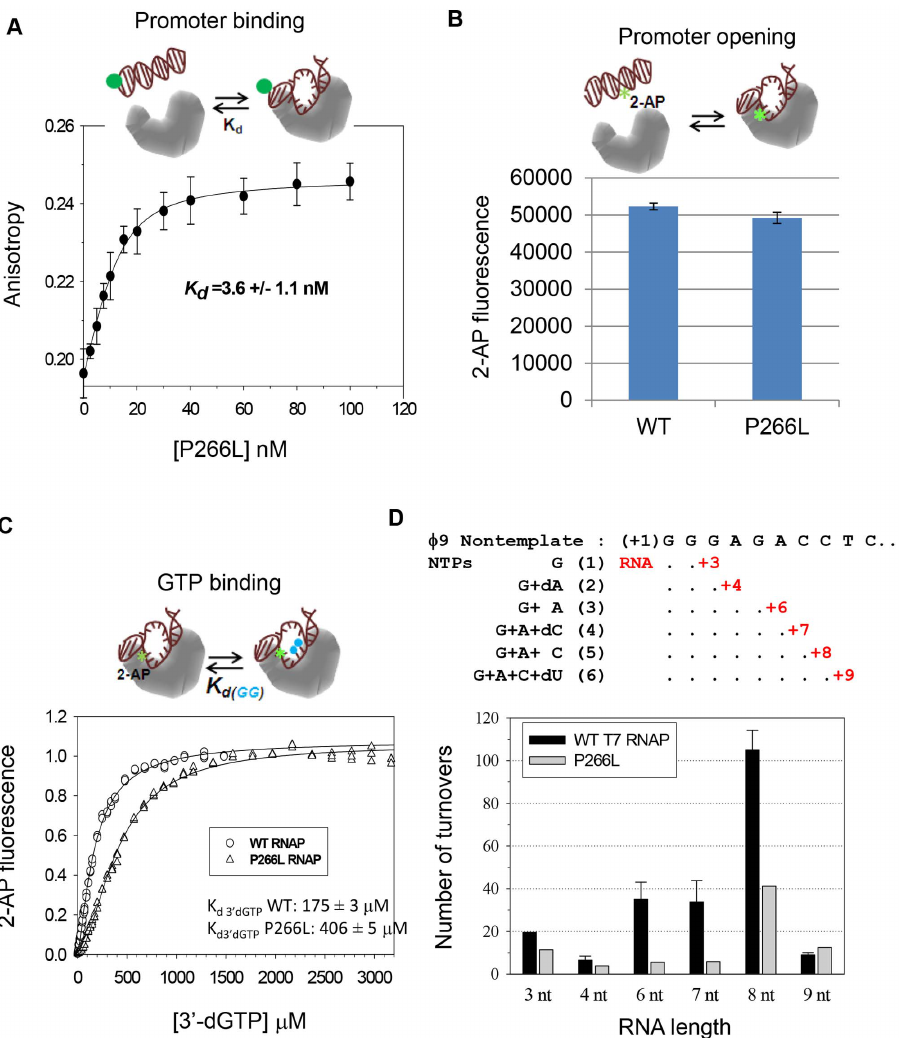
Figure 3. Promoter binding, opening, GTP binding and RNA turnover. (A) TAMRA fluorophore labeled promoter DNA (20 nM) was titrated with increasing P266L T7 RNAP (0 to 100 nM) and increase in fluorescence anisotropy was fit to the quadratic equation with K d of 3.6 6 1.1 nM. Similar to the WT T7 RNAP, the P266L mutant did not cause significant changes in the TAMRA fluorescence intensity ( , 10%) upon binding. Effect of the intensity changes on the fitting was insignificant and corrected the same way as reported previously [23]. Shown here are averaged values with standard deviations (error bars) from multiple independent measurements, from which K d was fitted. (B) The increase in 2-AP fluorescence at 2 4 in the template strand upon addition of WT and P266L indicate slightly lower promoter opening with P266L. The errors are standard deviation from 10– 15 measurements. (C) Initiating GTP binding was monitored from fluorescence increase in the 2-AP ( 2 4 position) labeled promoter DNA bound to T7 RNAP titrated with increasing 3 9 dGTP. The P266L binds to the initiating NTPs (3 9 dGTP) , 2 times weaker than WT T7 RNAP (175 m M versus 405 m M) and Hill coefficients are 1.3 6 0.02 and 1.7 6 0.03 for WT and P266L, respectively. The errors represent the fitting uncertainty. (D) A complex of WT or P266L T7 RNAP (2 m M) and promoter DNA (1 m M) was mixed with limited NTPs or NTP and 3 9 -deoxy NTP mixture for 2 min at 25 u C to allow RNA synthesis of the indicated lengths. The amount of RNA shown in m M is representative of the number of turnovers at each walked position for WT (black) and P266L (grey) T7